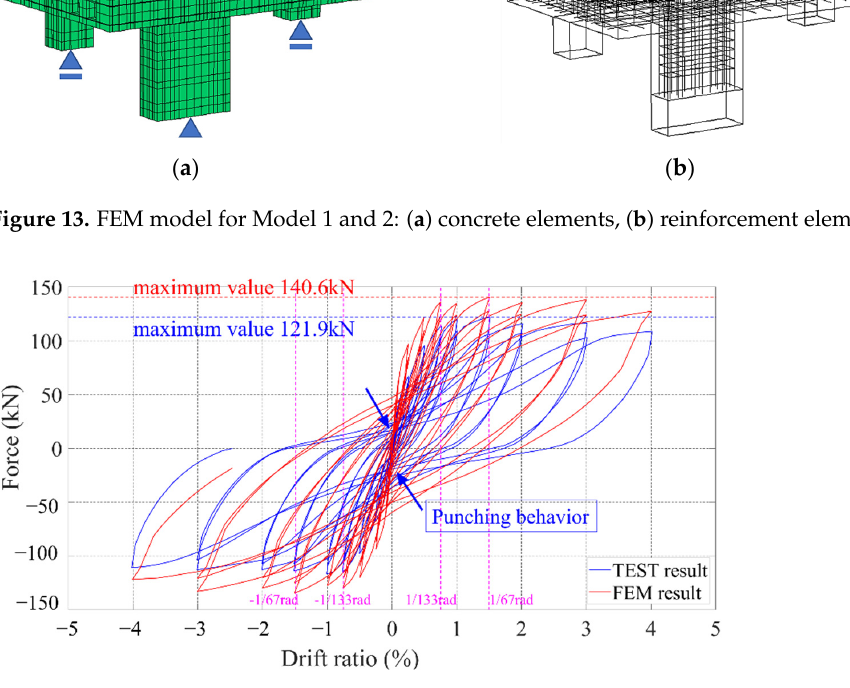
Figure 14. Comparison between test and FEM results of lateral force versus lateral drift ratio (%) relationship for Model 1.